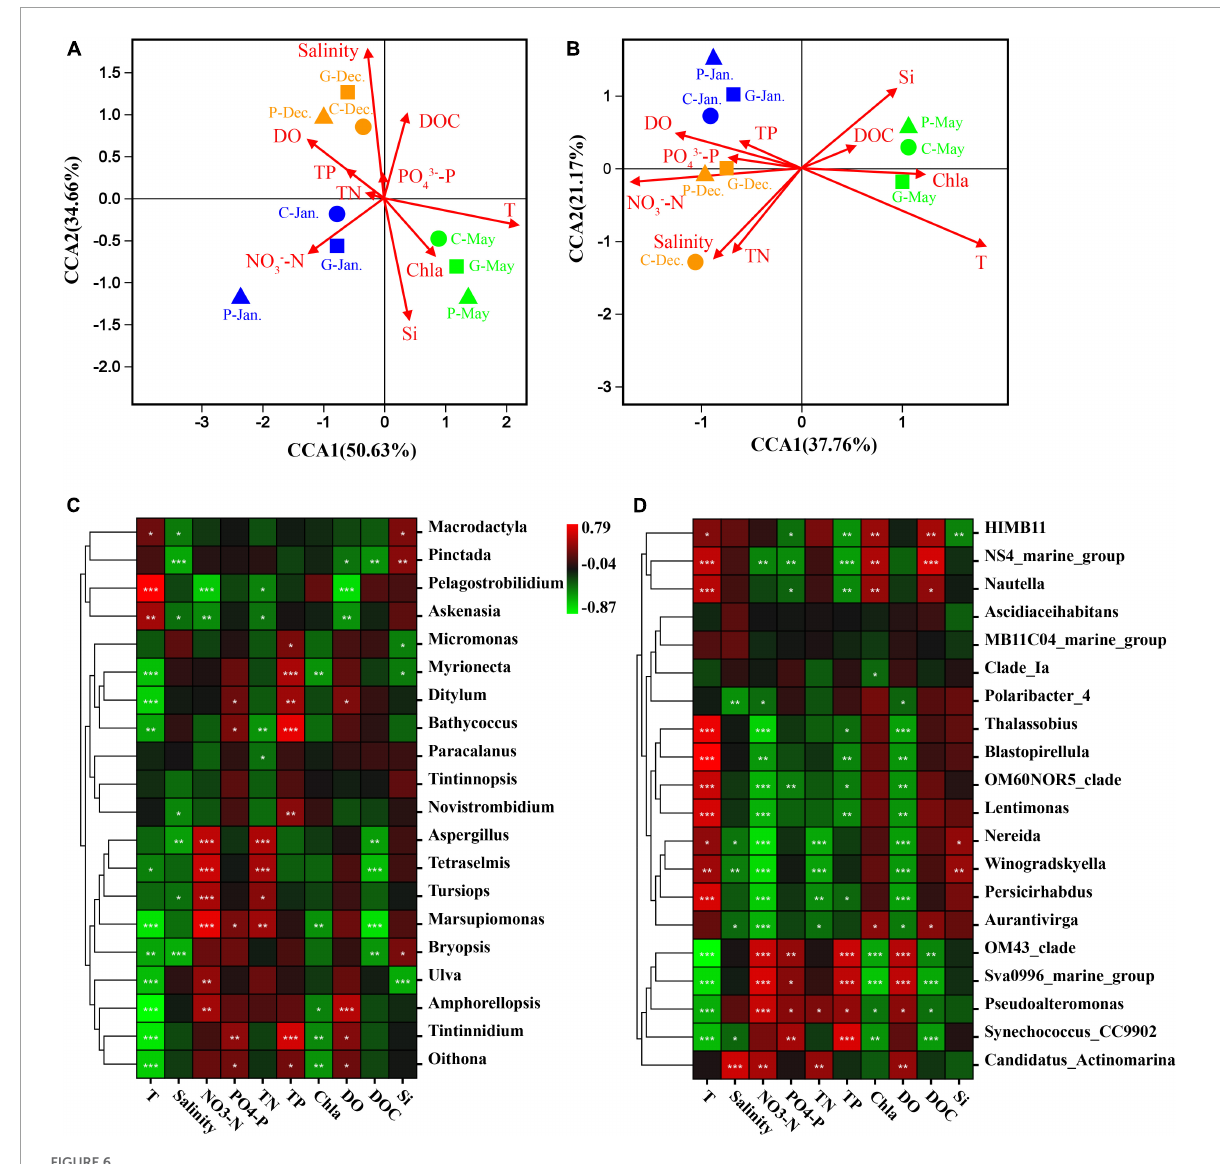
FIGURE6 Canonical correspondence analysis (CCA) biplot for the distribution of eukaryotic plankton (A) and prokaryotic plankton (B) communities with environmental variables. Triangles, samples from area P; squares, samples from area G; circles, samples from area C. Brown, samples in December 2019; blue, samples in January 2020; green, samples in May 2020. T, temperature; TP, total phosphorus; TN, total nitrogen; Si, reactive silicate; DO, dissolved oxygen; DOC, dissolved organic carbon; Chla, chlorophyll a . Spearman’s correlation analysis between seawater environmental factors and eukaryotic community (C) or prokaryotic community (D) . The corresponding intermediate heat-map value is the Spearman correlation coefficient r, r > 0: a positive correlation, r < 0: negative correlation. The symbols *, **, and *** indicate